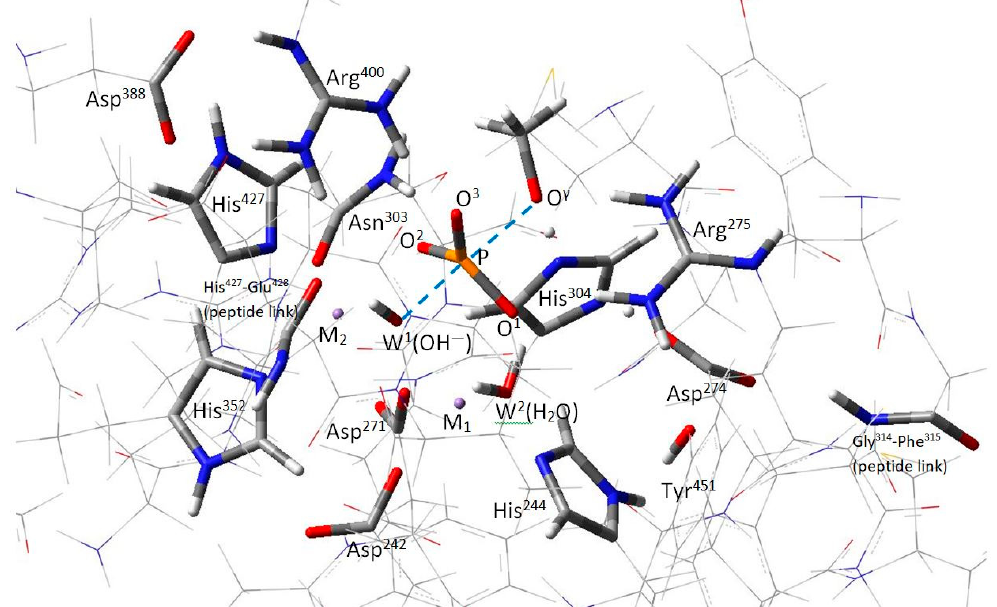
Figure 2. Two-level ONIOM(UB3LYP/6-31G(d):UPM7) model of the PP5 catalytic site. The functional groups of the “high-level” region (tubes) are conserved across the PPP gene family; the “low-level” region (wireframe) spans 33 residues. (Only the residues Gly 314 and Glu 428 located at the peptide linkages are not conserved.) M 1 and M 2 are Mn 2+ ions. The transition state for the backside attack by W 1 (OH − ) on methylphosphate dianion (the stand-in substrate) is shown; the substrate’s P-O γ bond is elongated and the phosphoryl group is flattened as part of a trigonal bipyramidal complex.